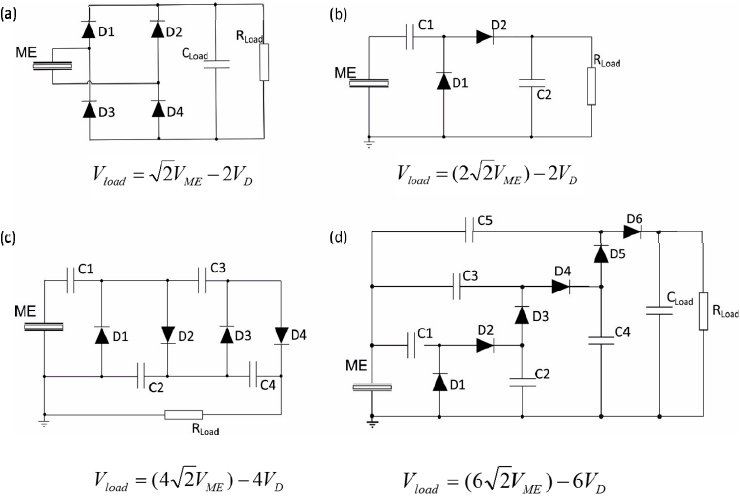
Figure 6. Schematic representation of a full-wave bridge voltage rectifier ( a ); one-stage